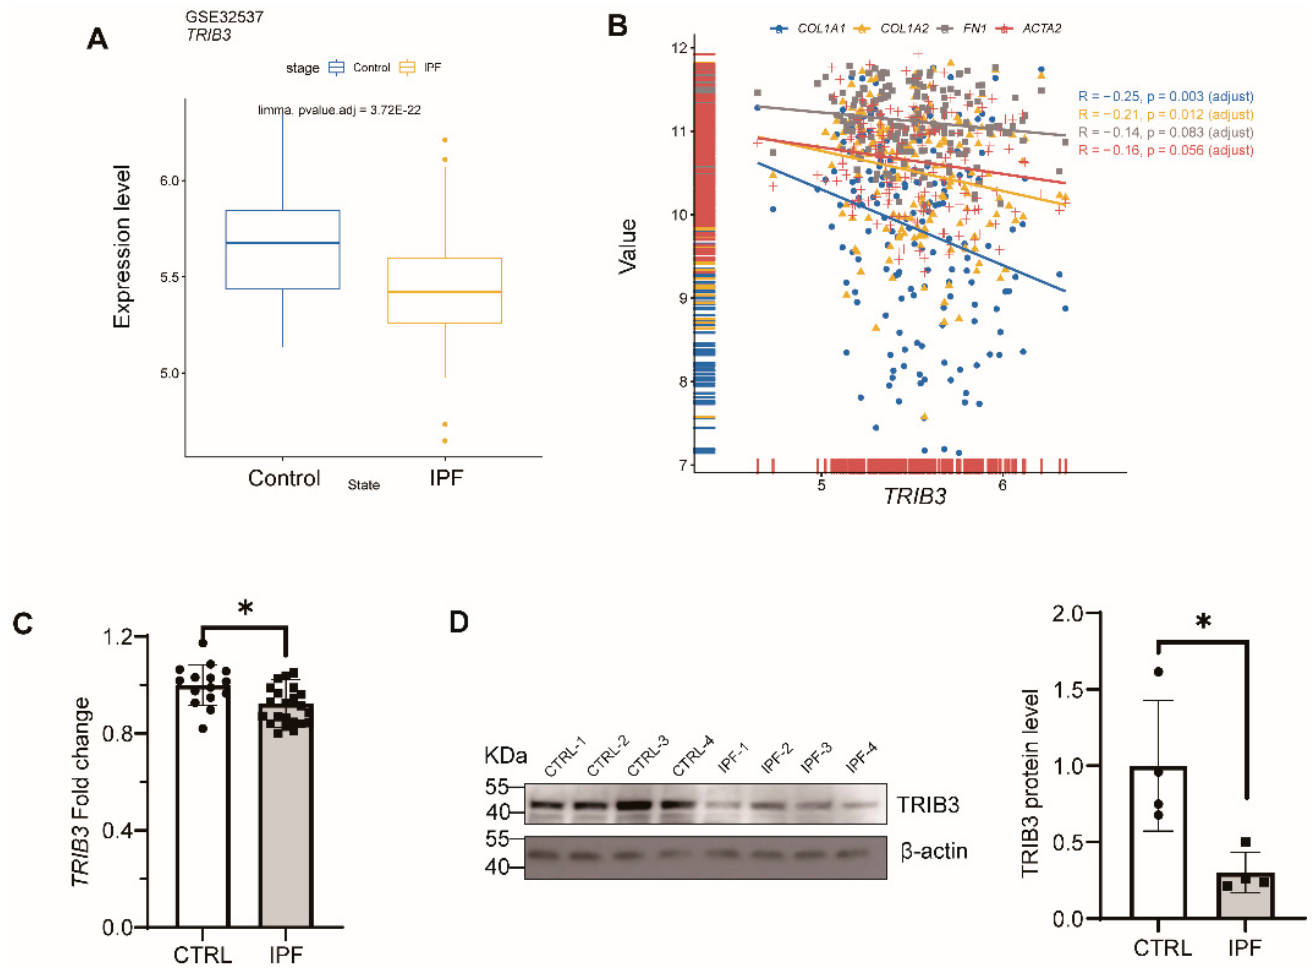
Figure 1. Down-regulation of TRIB3 in IPF lung. A. TRIB3 was down-regulated in IPF patients, which was profoundly validated from the Gene Expression Omnibus (GEO) RNA-seq dataset (GSE32537). Statistical analysis of the microarray was performed by R package “limma”. B. TRIB3 was negatively correlated with COL1A1 , COL1A2 , FN1 , and ACTA2 . Data were obtained from GSE32537 (Control = 50, IPF = 119) in the public database Gene Expression Omnibus (GEO). Spear- son rank analysis was used to analyze the correlation between TRIB3 and FN1 , ACTA2 , COL1A1 , and COL1A2 expression. C. TRIB3 was down-regulated from patients with IPF in transcription level. The statistical test used was the Mann–Whitney U test for comparisons between two groups. * p < 0.05.. D. Western blot analysis showed reduced TRIB3 expression in IPF lungs (N = 4) compared with healthy lungs (N = 4 ). The statistical test used was the Mann–Whitney U test for comparisons between two groups. * p < 0.05.